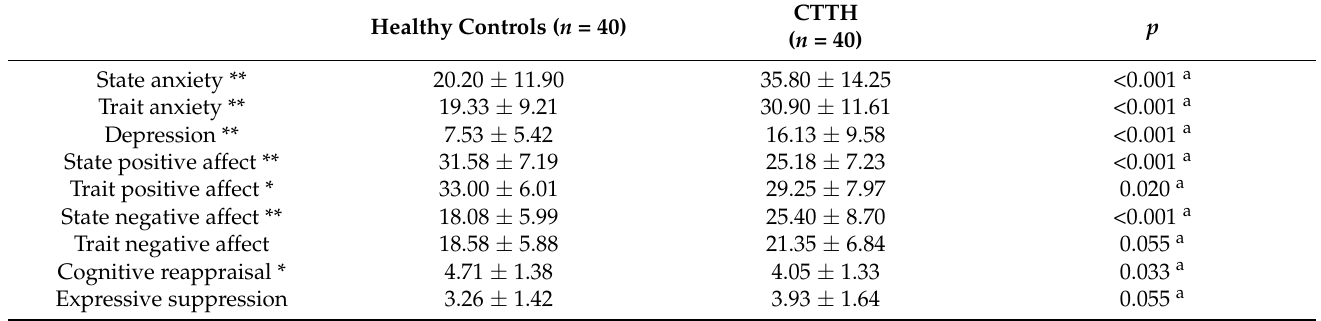
Table 3. Psychological differences between subjects with CTTH and healthy controls according to their questionnaire